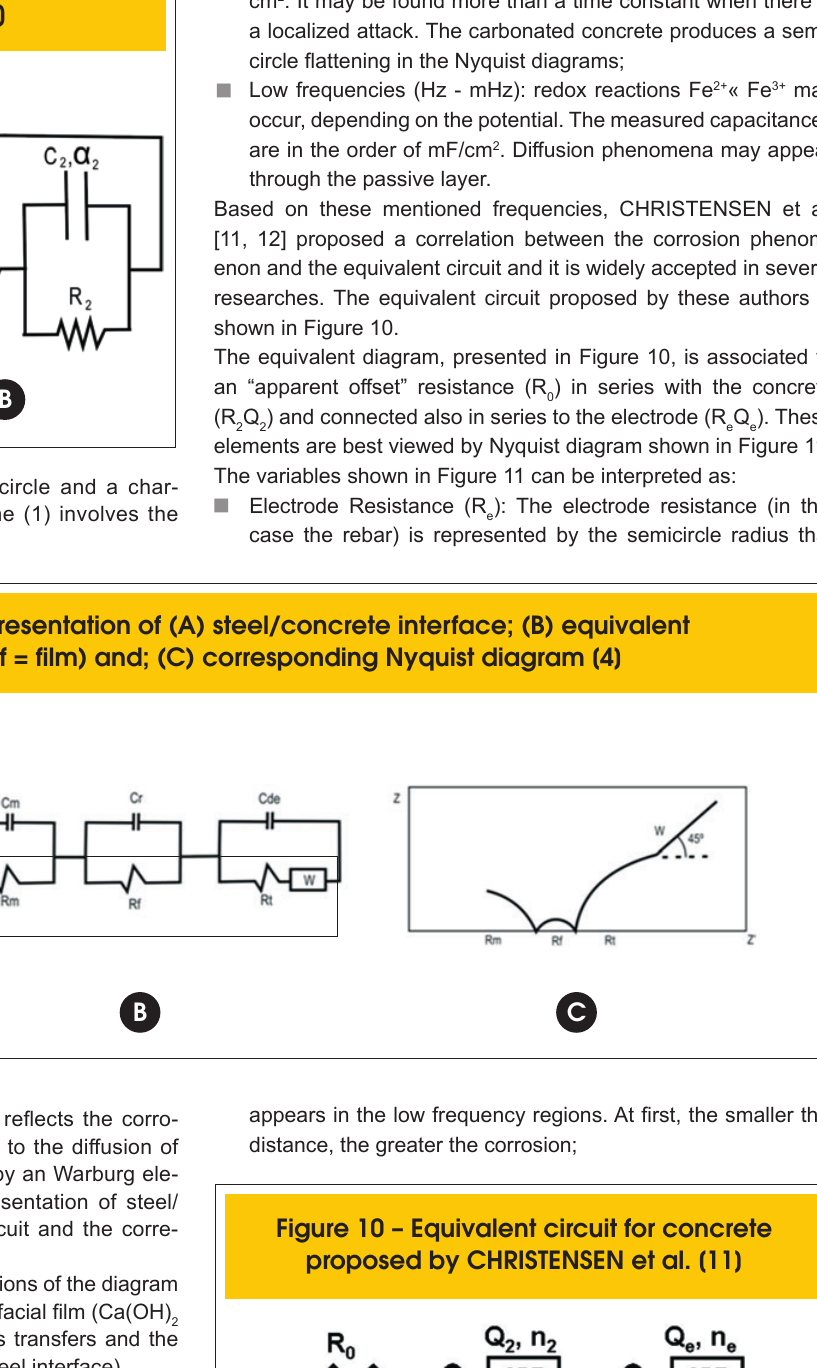
Figure 8 – (A) Simple equivalent circuit type Randles and; (B) Randles circuit modified with two time constants [10]